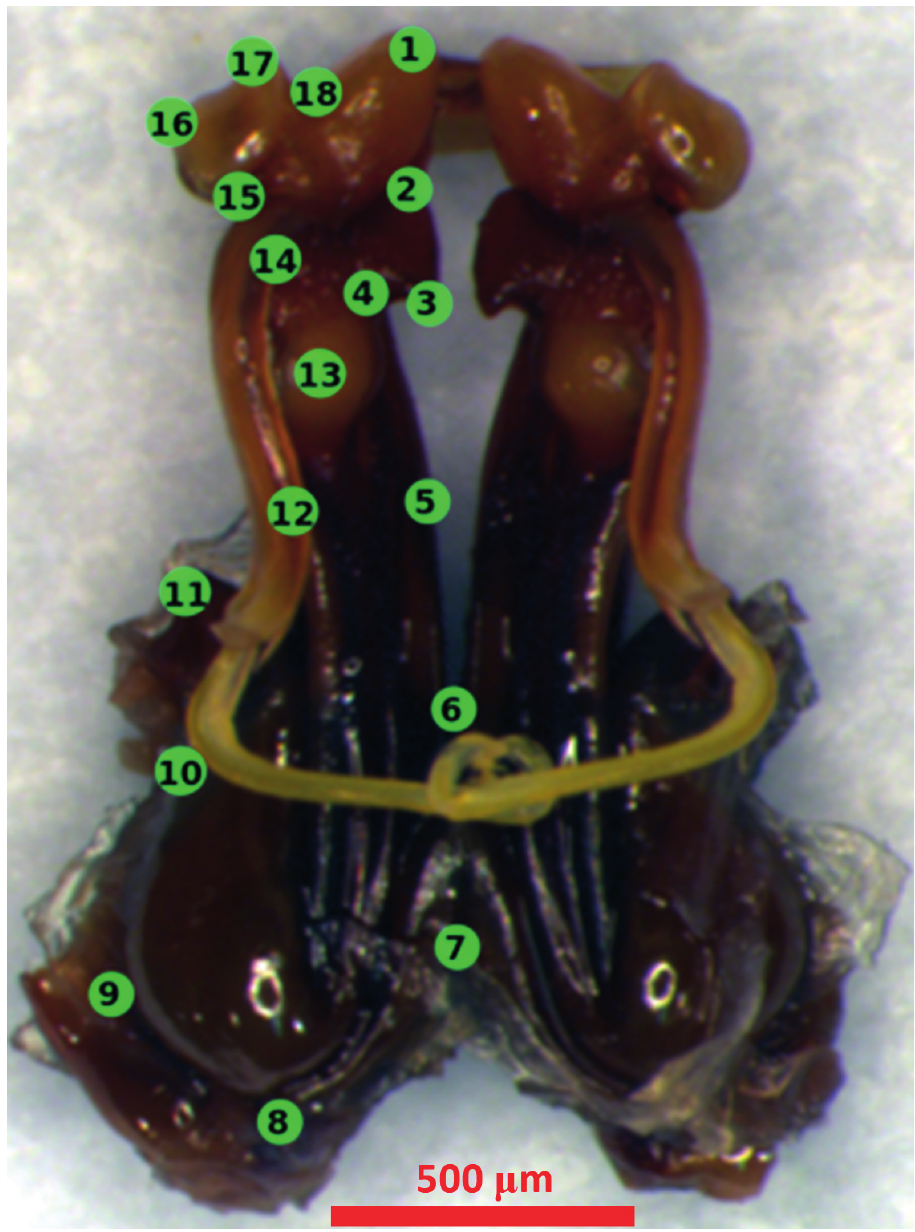
Figure 2. Landmarks used for analysis of gonopod shape variation in B. flavicollis